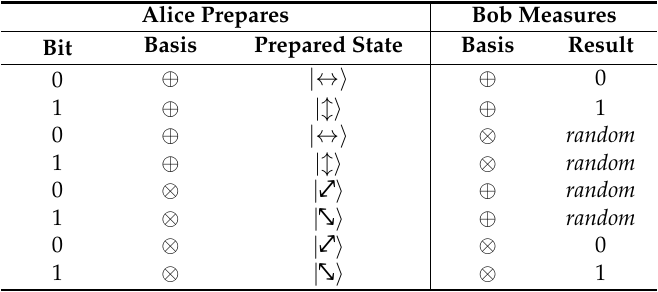
Table 1. Example BB84 Protocol.